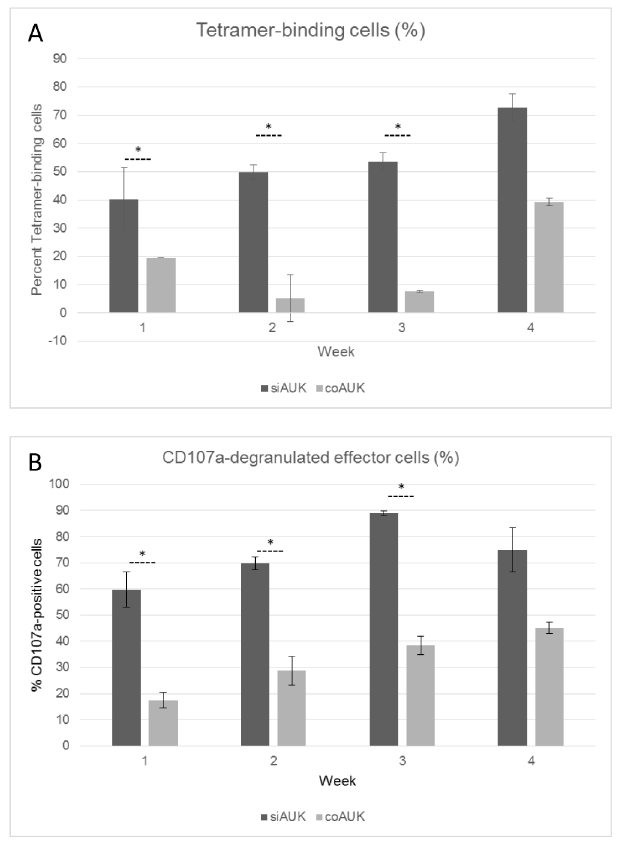
Fig 4. Enhanced persistence and expandability of siAUK-transduced CTLs. Bulk siAUK or coAUK cells (ie. non-enriched) were stimulated weekly with peptide-pulsed C1R-0201 cells at E:T = 2:1. (A) Tetramer- binding was assessed by labelling with a fluorophore-conjugated AUK 207-215 tetramer, and expressed as a percentage of V β 12+ CD8 cells. (B) CD107a degranulation was assessed in response to stimulation, and the number of CD107a-positive cells was expressed as a percentage of V β 12+ CD8